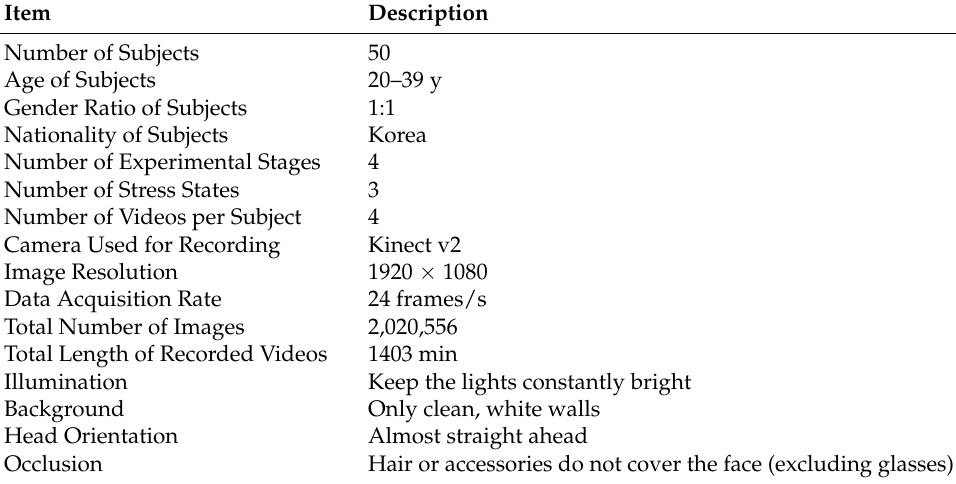
Table A1. Summary of the database construction settings and database